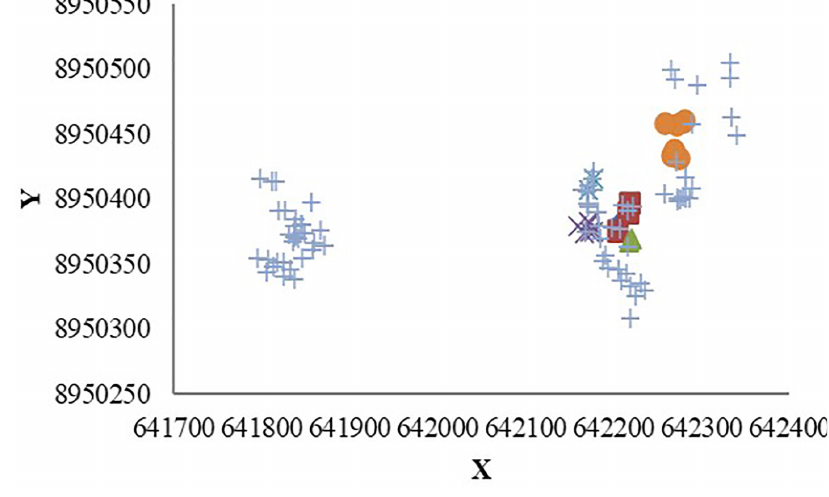
Figure 8. Geographic distribution of individuals with high genetic similarity within population 5 ( Guadua aff. lynnclarkiae ). The Y and X axes represent the geographical coordinates; the blue dots (+) represent non- clonal